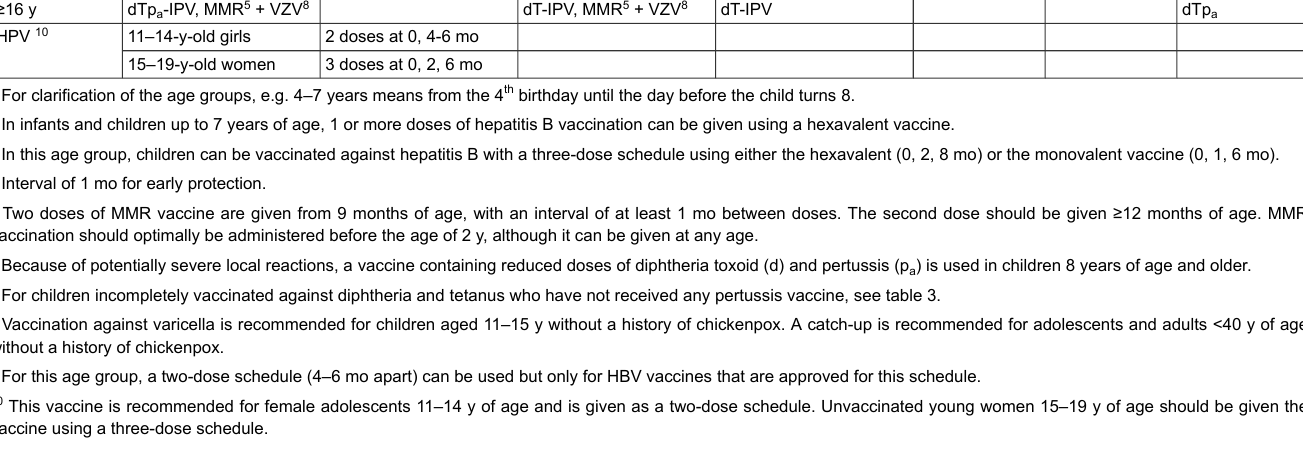
Table 2: Vaccination schedule for incompletely immunised children and